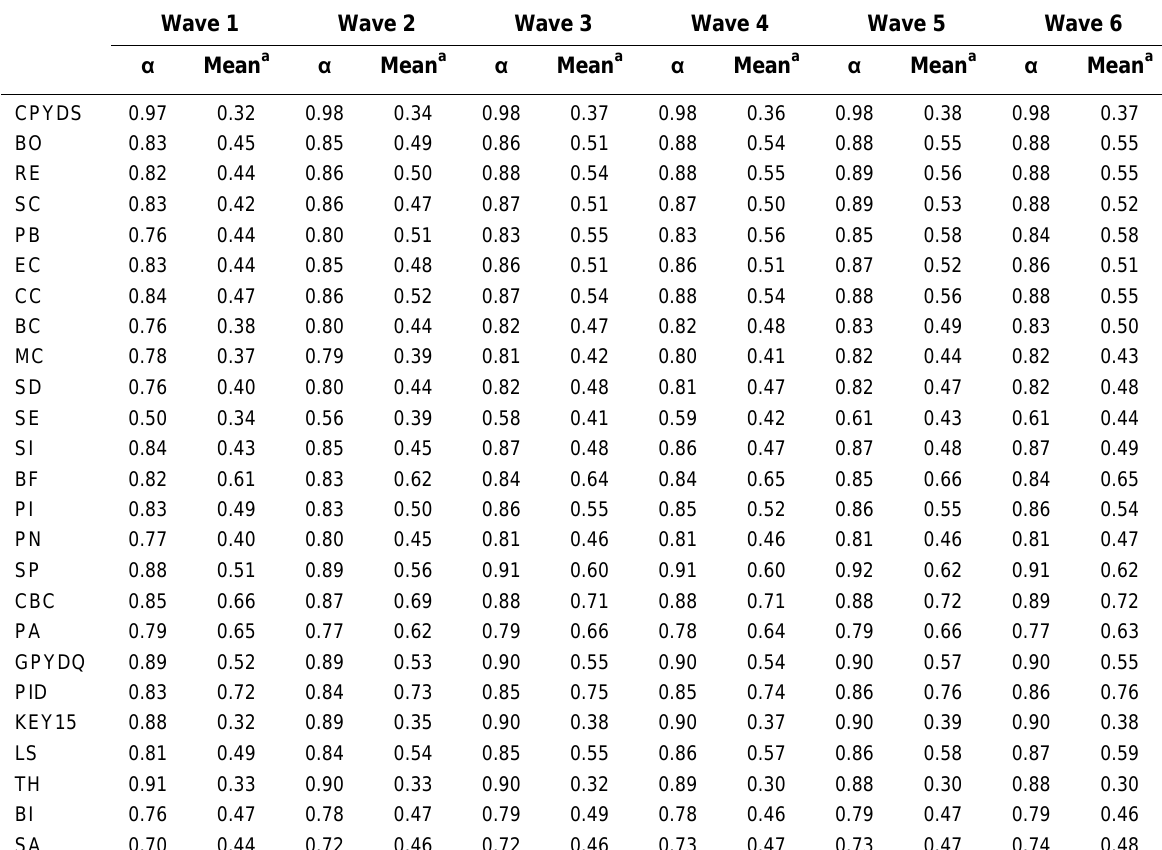
Internal Consistency and Mean Interitem Correlations for All